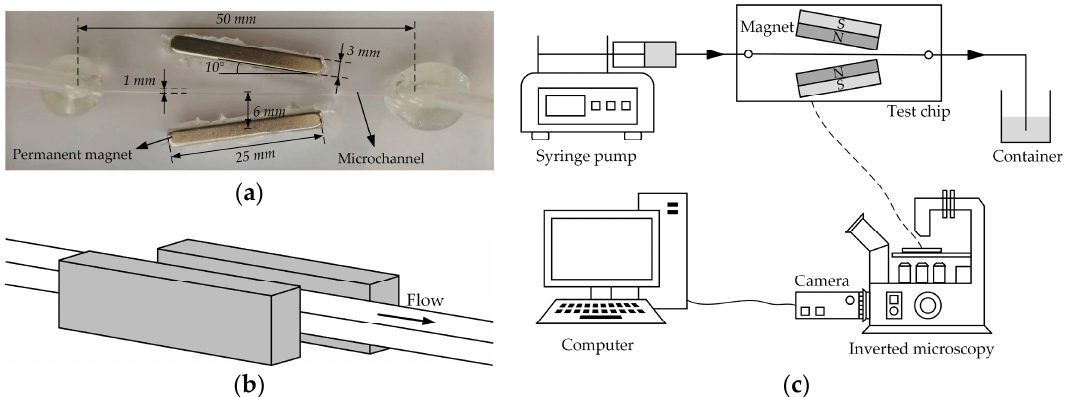
Figure 3. Experimental chip and system: ( a ) picture of the microfluidic chip with permanent magnets embedded in polydimethylsiloxane (PDMS); ( b ) schematic diagram of the spatial position of the channel and magnet, and note that the centerline of the permanent magnet is on the same plane as the centerline of the channel; ( c ) the experimental setup.